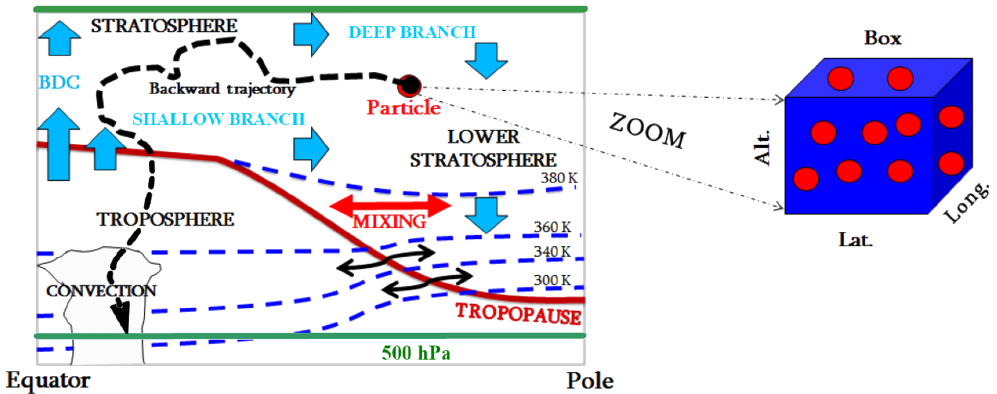
Figure 1. A schematic representation of the backward Lagrangian trajectories of air parcels starting in a (latitude × longitude × altitude) grid box. Here the longitudinal extend of the box should be seen as the whole latitudinal